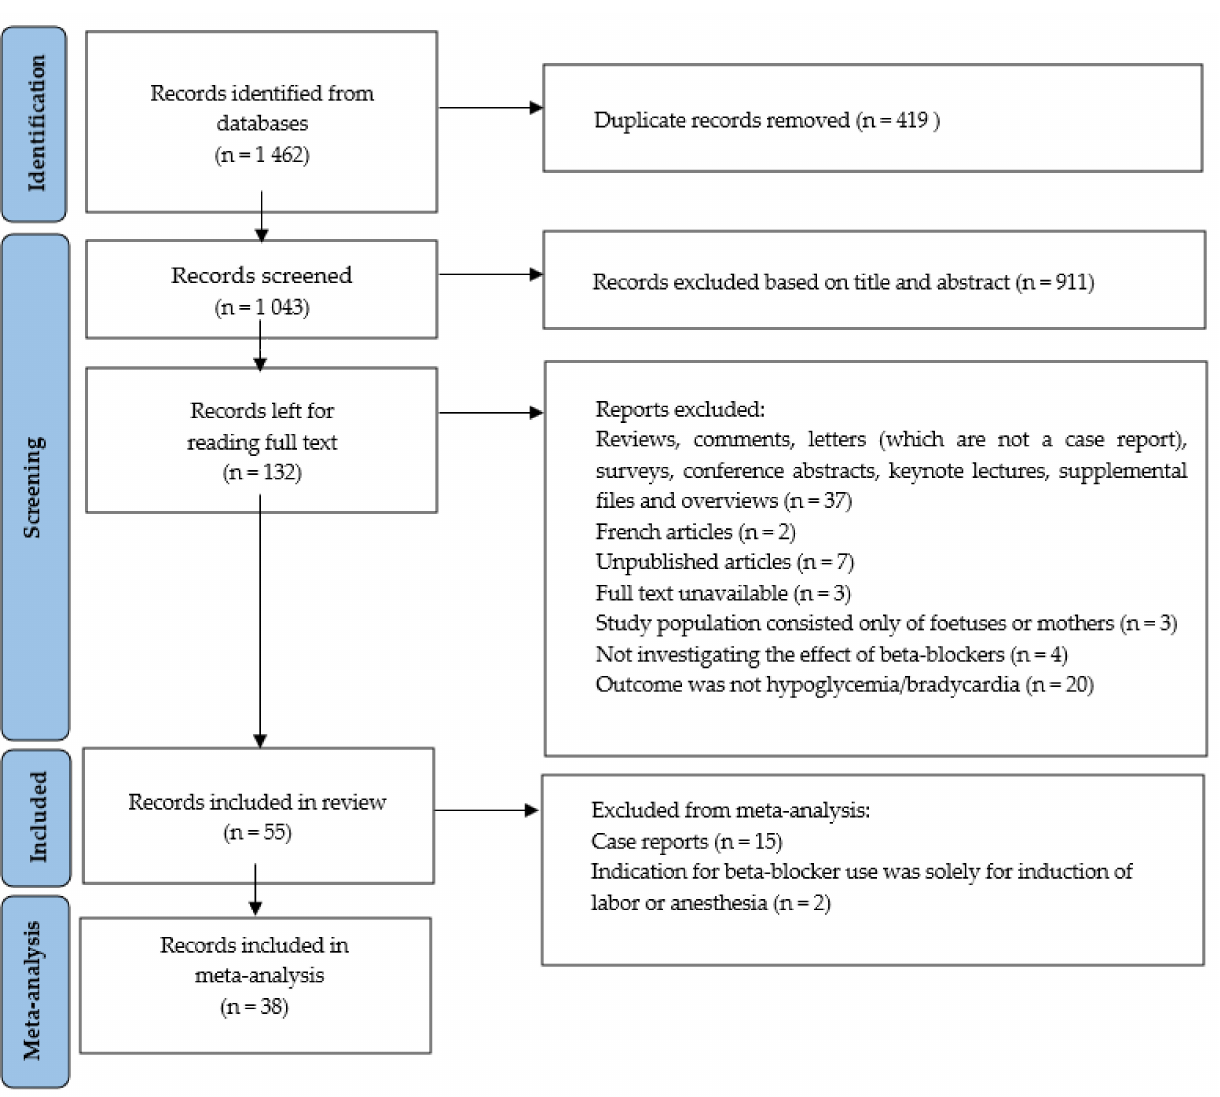
Figure 1. Overview literature search according the PRISMA